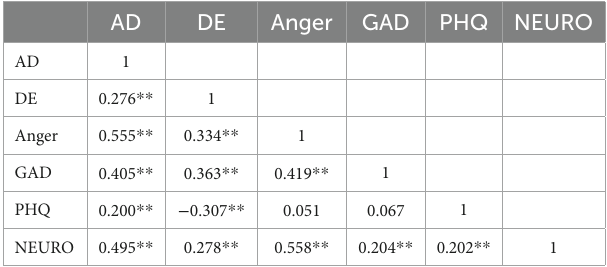
TABLE 4 Correlation between affective lability, anxiety, depression, and neuroticism.